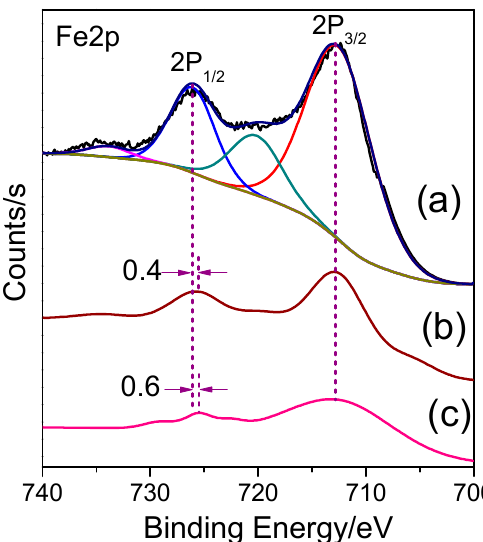
Figure 1. The high-resolution Fe 2p XPS spectra of ( a ) NiFe–LDH films, ( b ) Fe-doped NiFe–LDH films, and ( c ) Fe-doped NiAl–LDH films.